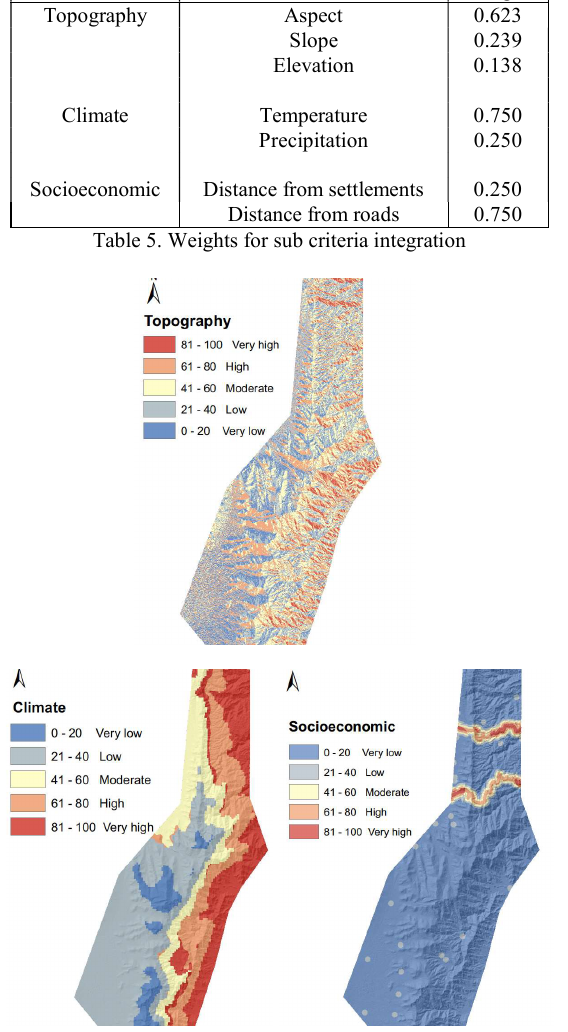
Figure 6. Maps of sub criteria integration